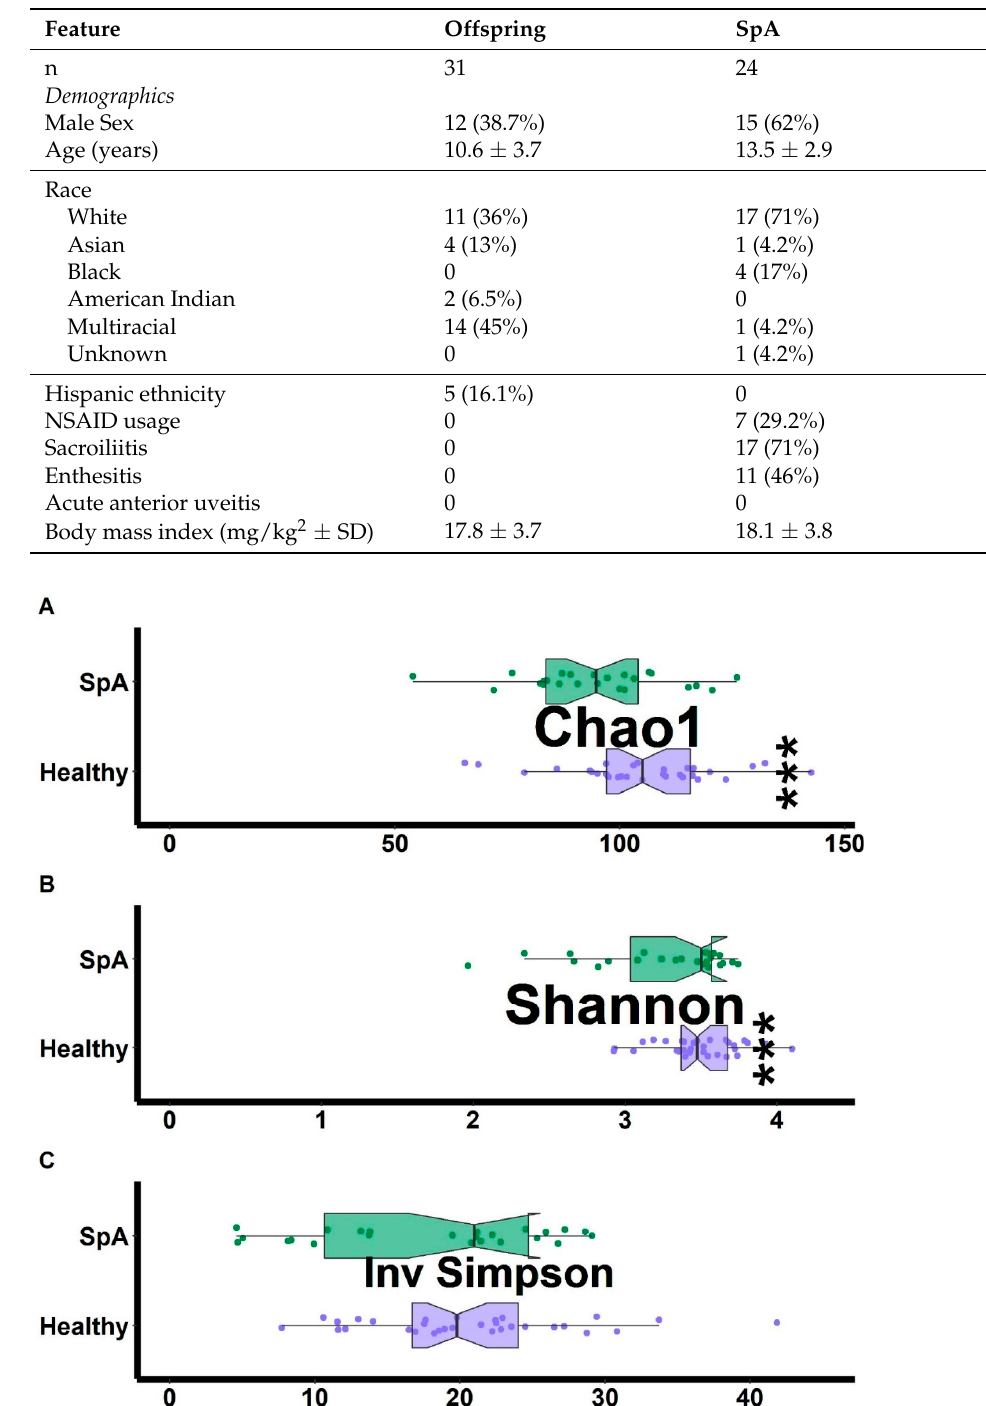
Figure 4. Alpha diversity measures comparing HLA-B27+ offspring of AS patients to HLA-B27+ treatment-naïve children with SpA. The Chao1 measure of richness ( A ) along with the Shannon ( B ) and inverse Simpson measures of evenness ( C ) are shown. Asterisks indicate statistically significant difference ( p <